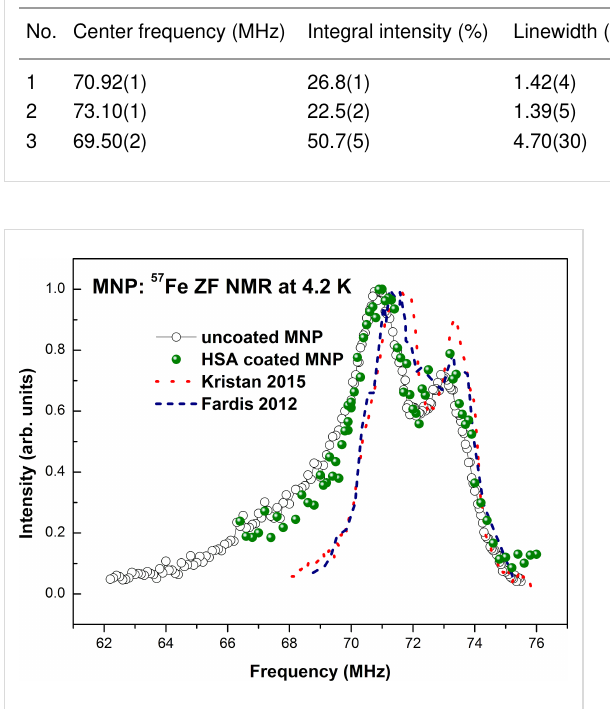
Table 2: Parameters of the NMR and Mössbauer spectra calculated from experimental data for the uncoated sample. The center frequency, the inte- gral intensity and the line width are the parameters of the Gaussian approximation of the NMR spectra; the local magnetic field values H loc at the Fe site were extracted from the experimental ZF-NMR 57 Fe spectrum measured at 4.2 K, (Figure 9) and H max is the field obtained from the Mössbauer measurements at 10 K. ZF-NMR Mössbauer